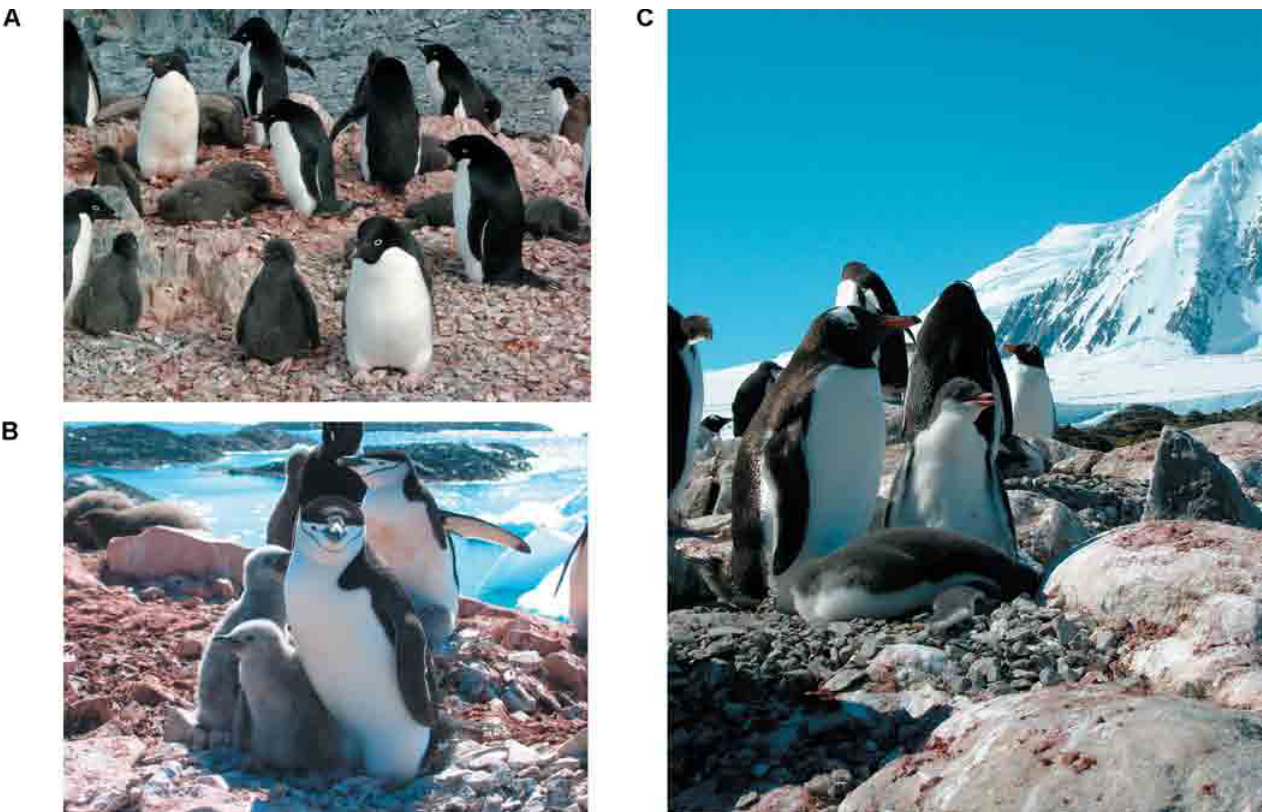
Figure 2. Antarctic Penguins Show Striking Contrasts in Their Relationship to the Sea Ice (A) Ice-dependent Adélie penguins, at their nesting grounds on Anvers Island, have lost 10,000 breeding pairs since 1975. (B) Ice-avoiding chinstrap penguins at Anvers Island are increasing in number and range. (C) Breeding gentoo penguins—an ice-avoiding species that has not inhabited Anvers Island sites for at least 800 years—are turning up at Palmer